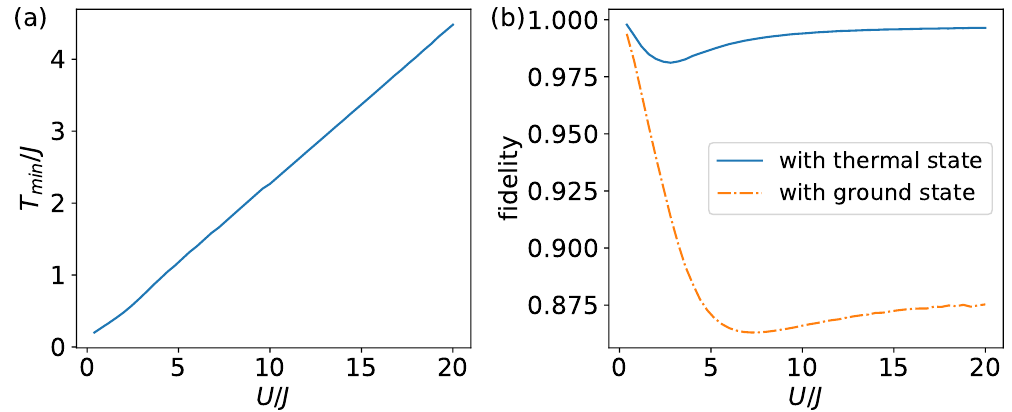
Figure 9: (a) The minimal temperature of the effective thermal bath that can be engineered as a function of the interaction strength. (b) The fidelity between the steady state and the corresponding thermal state (blue solid line) and the ground state (orange dot-dashed line). The parameters are M = 4, N = 4, γ = 0.01 J . both at finite temperatures and for the preparation of the ground